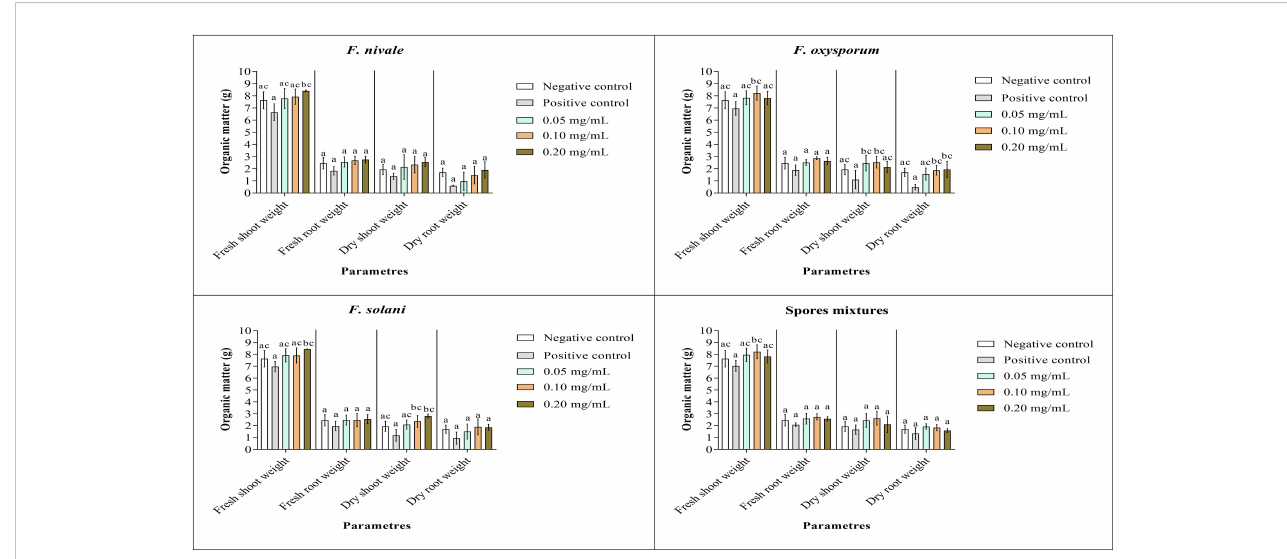
FIGURE 9 Organic matter of ryegrass after four weeks of treatment with carvacrol in normal soil under greenhouse. Means (± SD, n = 3) denoted by the same letter indicate no signi fi cant difference according to Tukey ’ s multiple range tests at p<